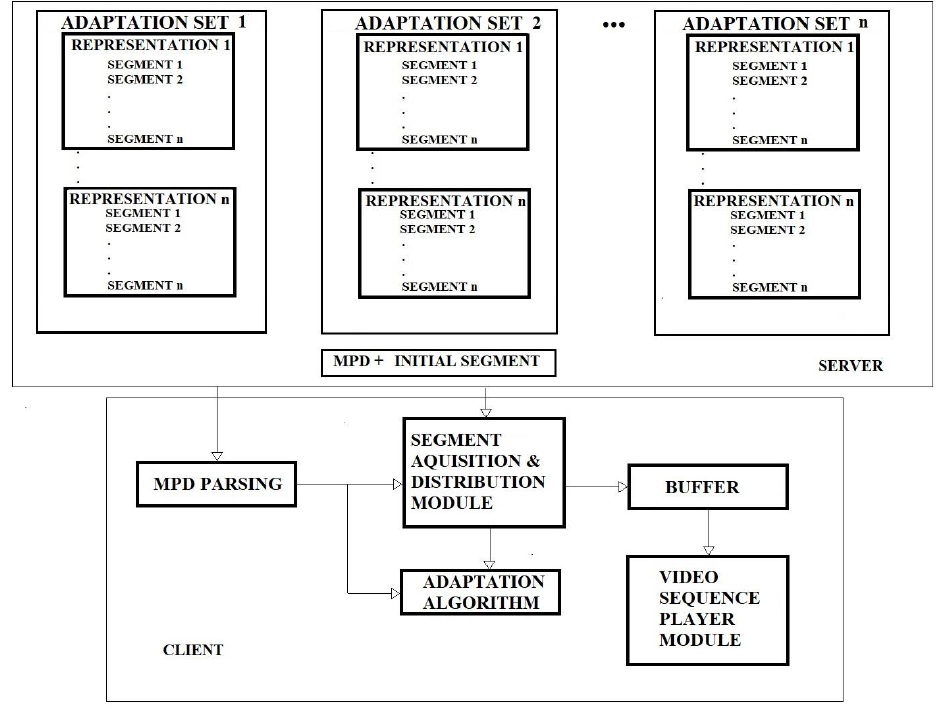
Figure 1. Overview of a system based on MPEG DASH.